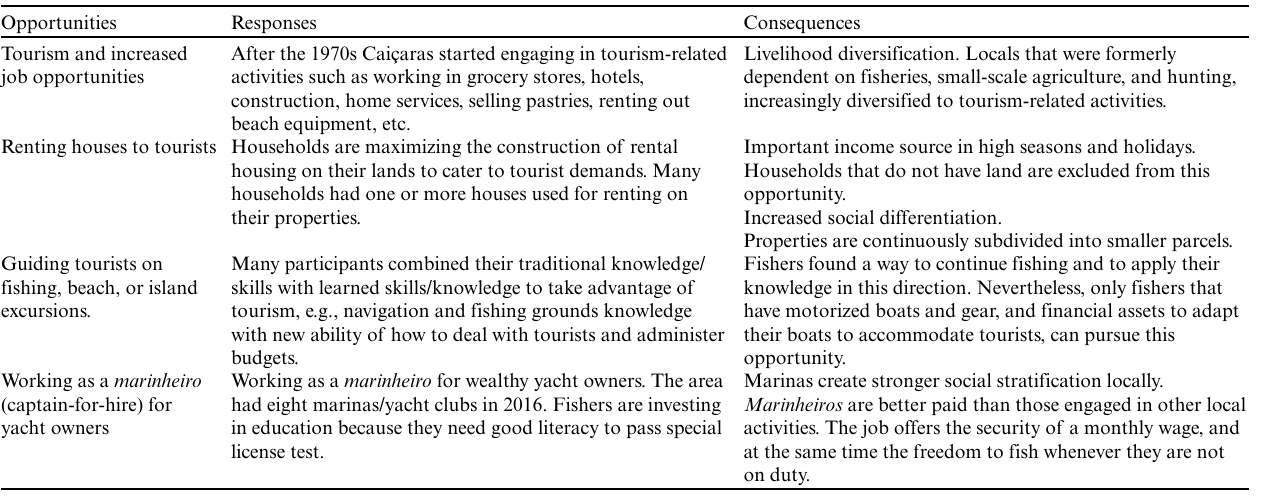
Table 3 . New opportunities that arose in the study area after the 1970s, responses and consequences for participants’ livelihoods. Opportunities